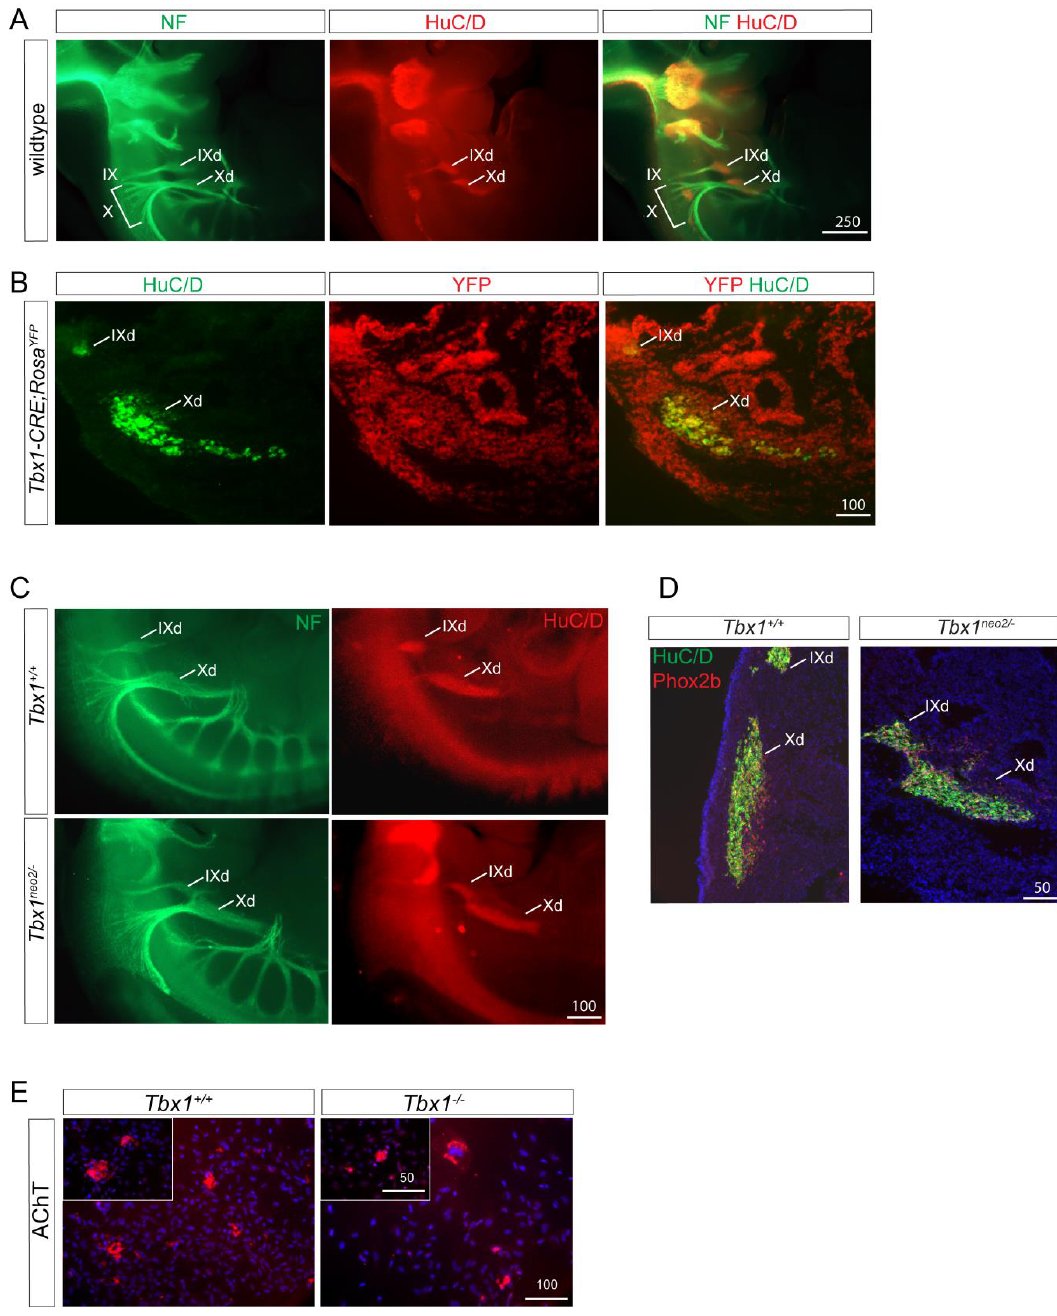
Figure 3. Defects in cranial ganglia in Tbx1 mutants. ( A ) In wildtype E11.5 embryos, neurofilament labelling demonstrate aggregates of nerve forming the proximal IX th and the X th ganglia (IX and X in A, and nerve fibres projecting ventrally to reach distal sensory ganglia of these nerves (HuC/D positive IXd and Xd in A). ( B ) E11.5 Tbx1CRE-Rosa YFP embryos were stained for the cNCC marker AP2α together with YFP as a marker for the Tbx1 -lineage. Co-localisation observed at the level of the IX th and X th ganglia. ( C ) In Tbx1 neo2/− E11.5 embryos, HuC/D neurons are in spindle shaped ganglia but are misplaced and fused. ( D ) E11.5 Tbx1 neo2/− embryos are stained positively for the neuronal marker Phox2B. ( E ) cNCCs derived from explanted neural tubes of Tbx1 +/− and Tbx1 −/− E8.75 embryos were cultured for 10 days and stained with the parasympathetic marker acetylcholine transporter (AChT). Scale bars are in μm.